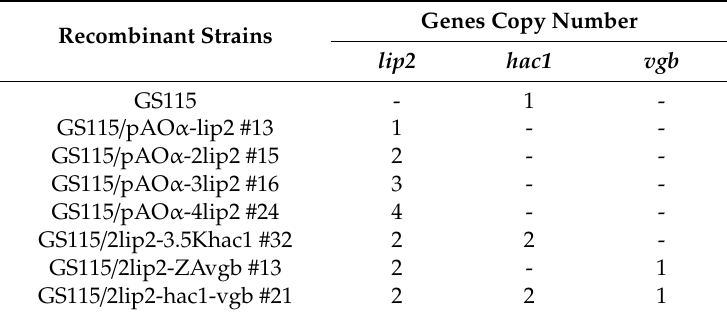
Figure 1. Lipase activity of recombinant strains harboring di ff erent copies of lip2 gene expression cassettes. Data are the mean ± standard deviation of triplicate experiments. Table 1. qPCR analysis for recombinant